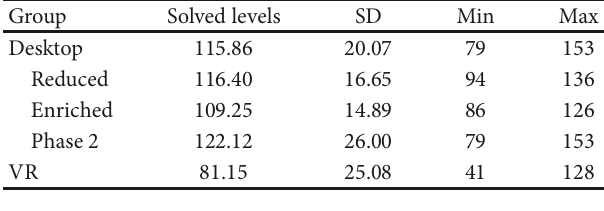
Table 3: Gameplay progress at the end of the experiment.